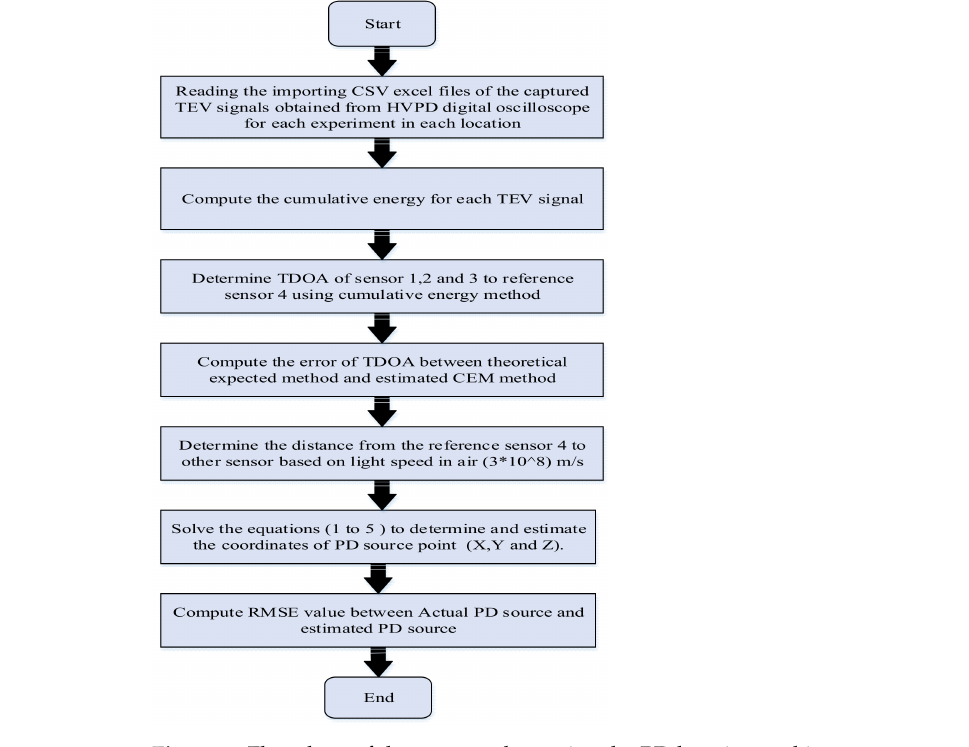
Figure 8. Flowchart of the steps to determine the PD location and its accuracy.